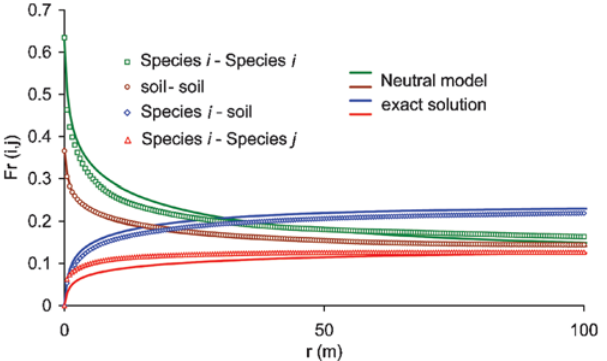
Figure 3. Beta-diversity of intertidal vegetation species under the neutral assumption. The hollow symbols represent observational values, while solid lines are plots of eq. (1) from the neutral model fitted on